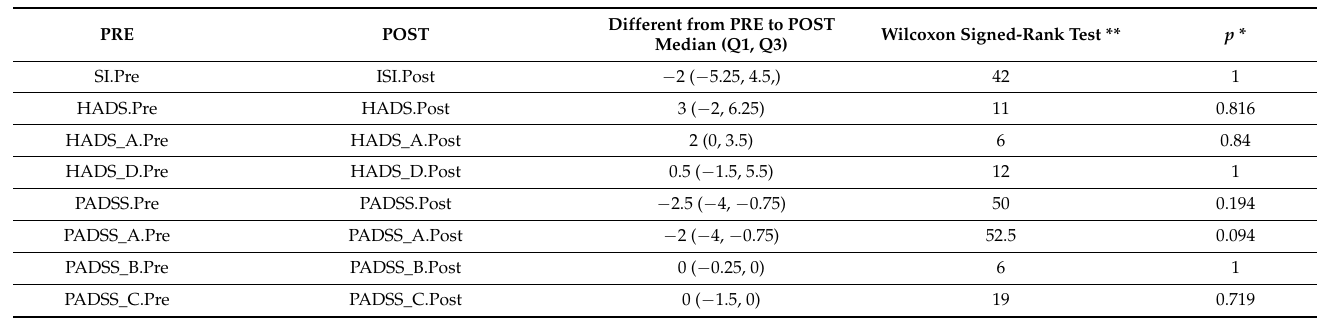
Table 2. Results of Wilcoxon signed-rank tests comparing two time points ( PRE , initial test scores following the group CBT-NREMP intervention and POST , subsequent postal survey findings) and scores for ISI, HADS and PADSS